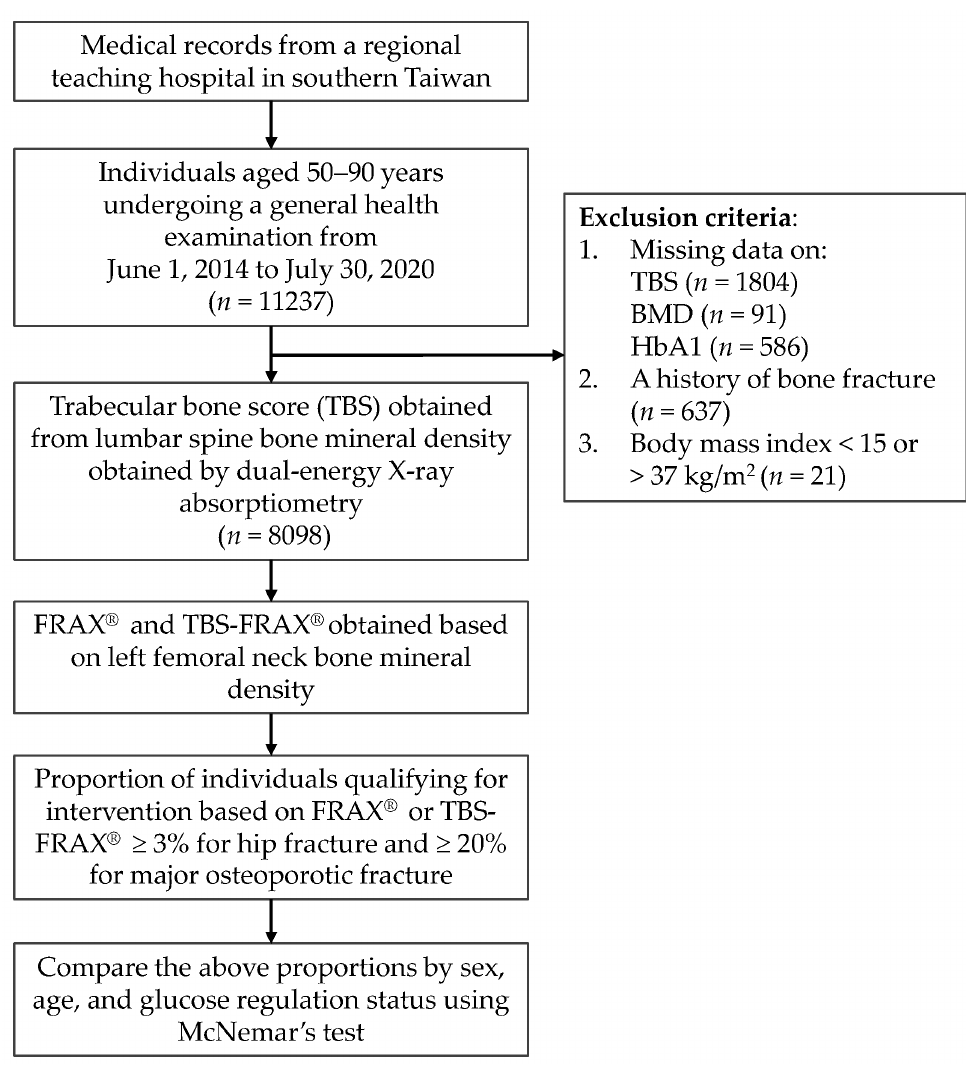
Figure 1. Study Figure 1. Study flowchart.